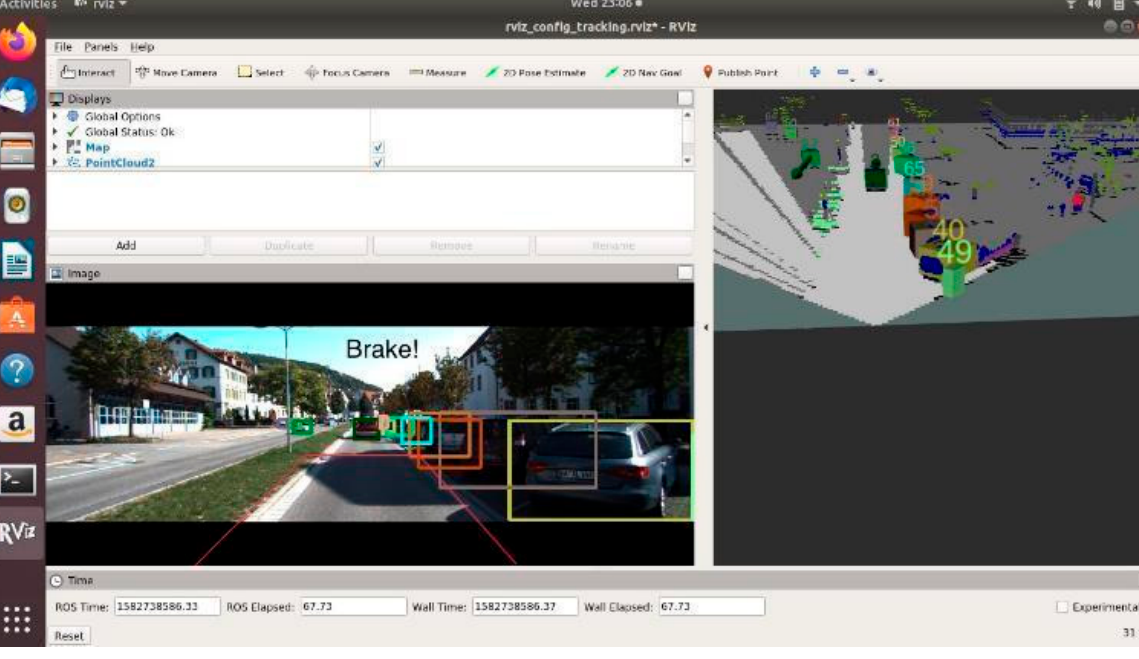
Figure 19. Unsafe scenario detected by OCSF.